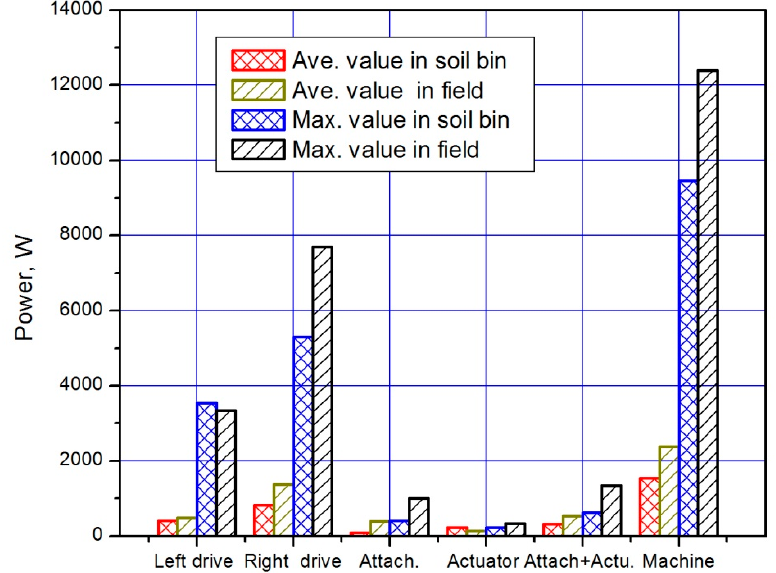
Figure 7. Overall power consumption of the robot for the weeding task.